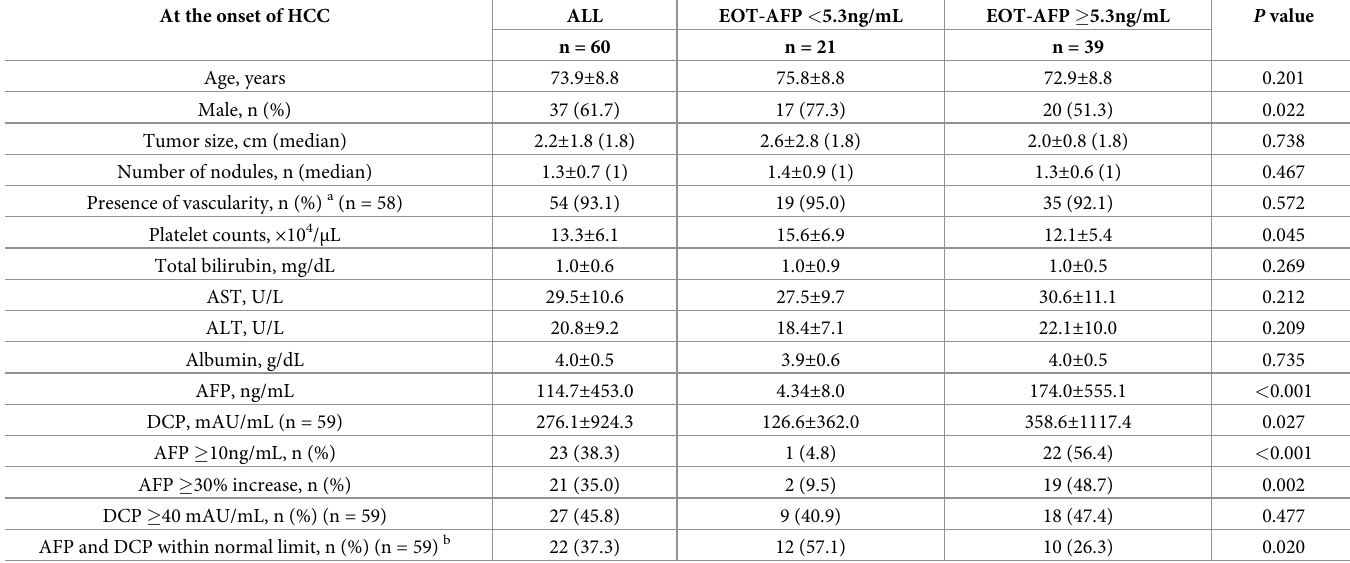
Table 6. Comparison of the data at the onset of hepatocellular carcinoma (HCC). At the onset of